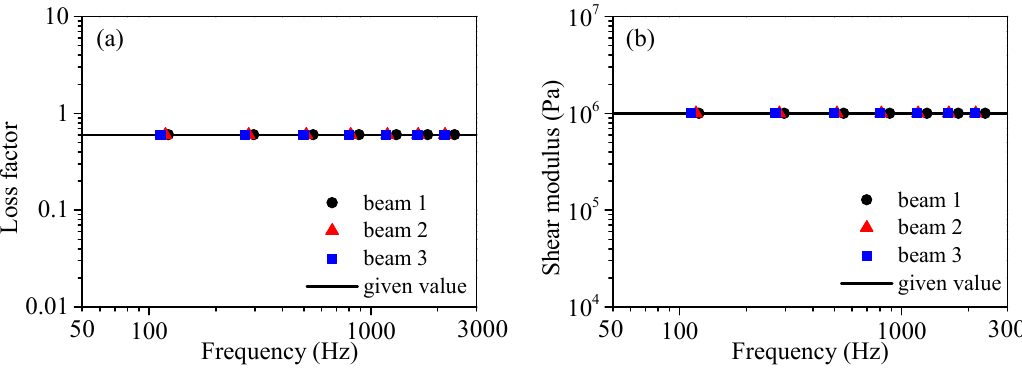
Figure 3. Simulation results of constant loss factor and shear modulus by three sandwich beams: ( a ) modal loss factors and ( b ) modal shear moduli.